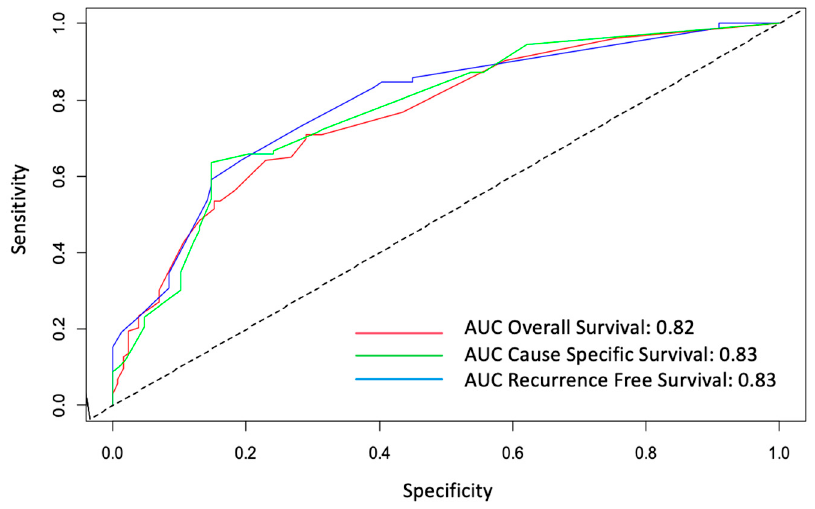
Figure 4. ROC curves for overall (OS), cause-specific (CSS) and recurrence-free survivals (RFS). AUC: area under the curve.